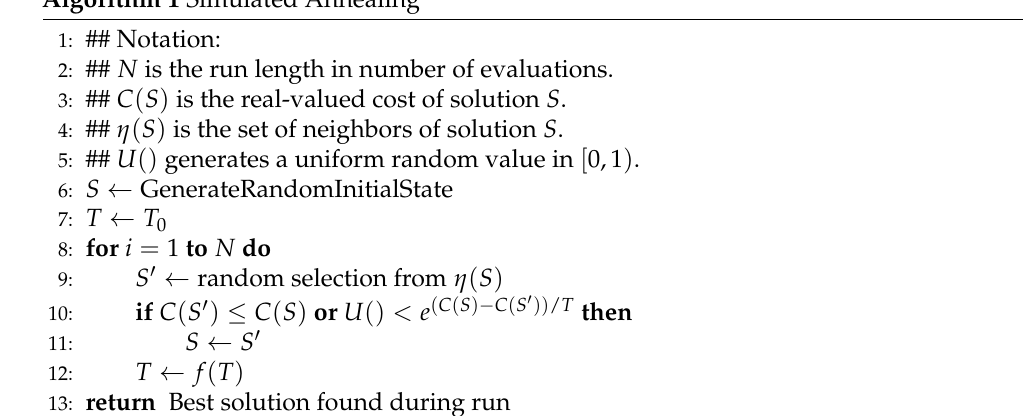
Algorithm 1 Simulated